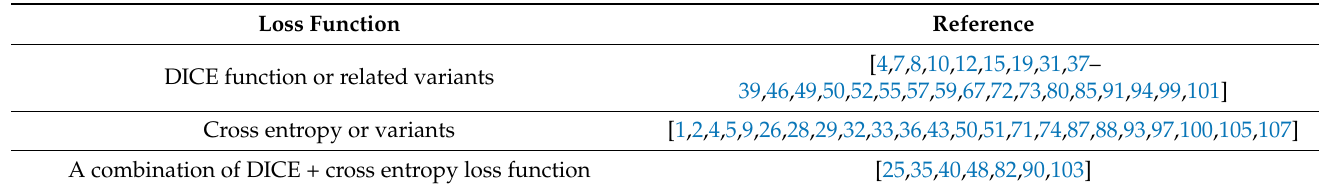
Table 5. Loss functions most frequently used for the segmentation of musculoskeletal structures.